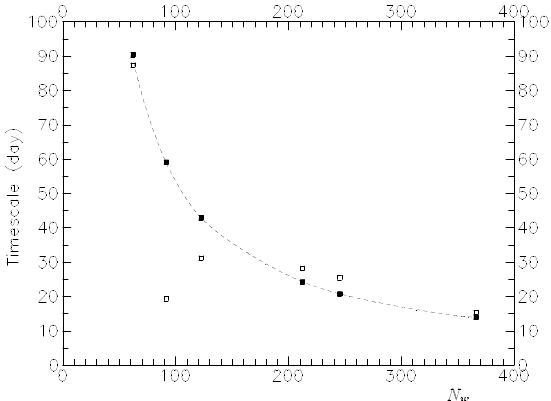
Figure 4. Long timescale versus the dimensionless number N w when the radiative cooling rate is 1 ◦ C/day. Symbol (cid:3) represents the CRM simulation results; symbol (cid:4) and the dashed line represent the analytic result from Equation (2.4).